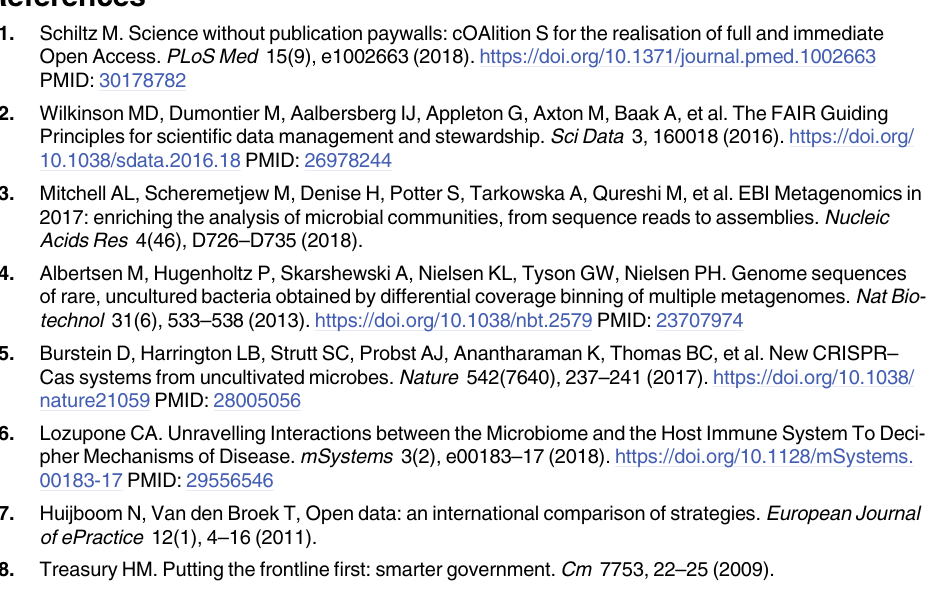
S1 Fig. Trend of accessibility of metagenomes over time. Data referrals for the year 2016 till March 2019. (TIFF) S2 Fig. Difference in proportion of papers with accessible metagenomic data across scien- tific fields. Data collected according to Clarivate Web of Science. (TIFF) S3 Fig. Differences between the proportion of data accessibility. Data related to the (A) pub- lisher, (B) journal impact factor, and (C) number of papers published. Trendlines in (B) and (C) are from the GLMs cited in Table 1. (TIFF) S4 Fig. Graphical depiction of multicollinearity between predictors used for statistical models.